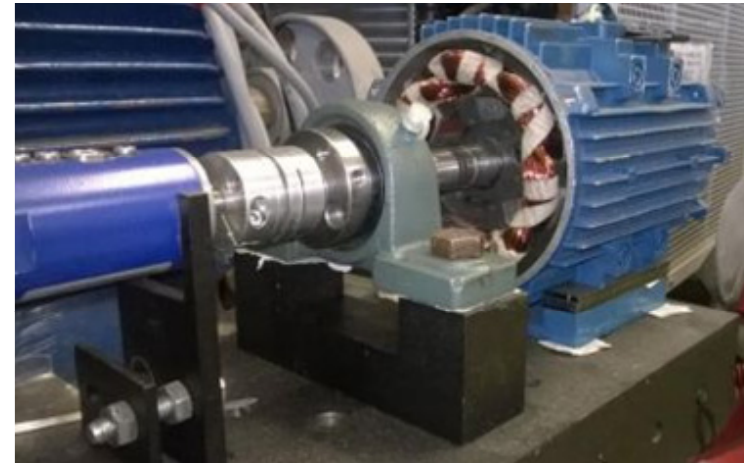
Figure 4. Switched reluctance motor mounted on a test bench with visible rotor poles.